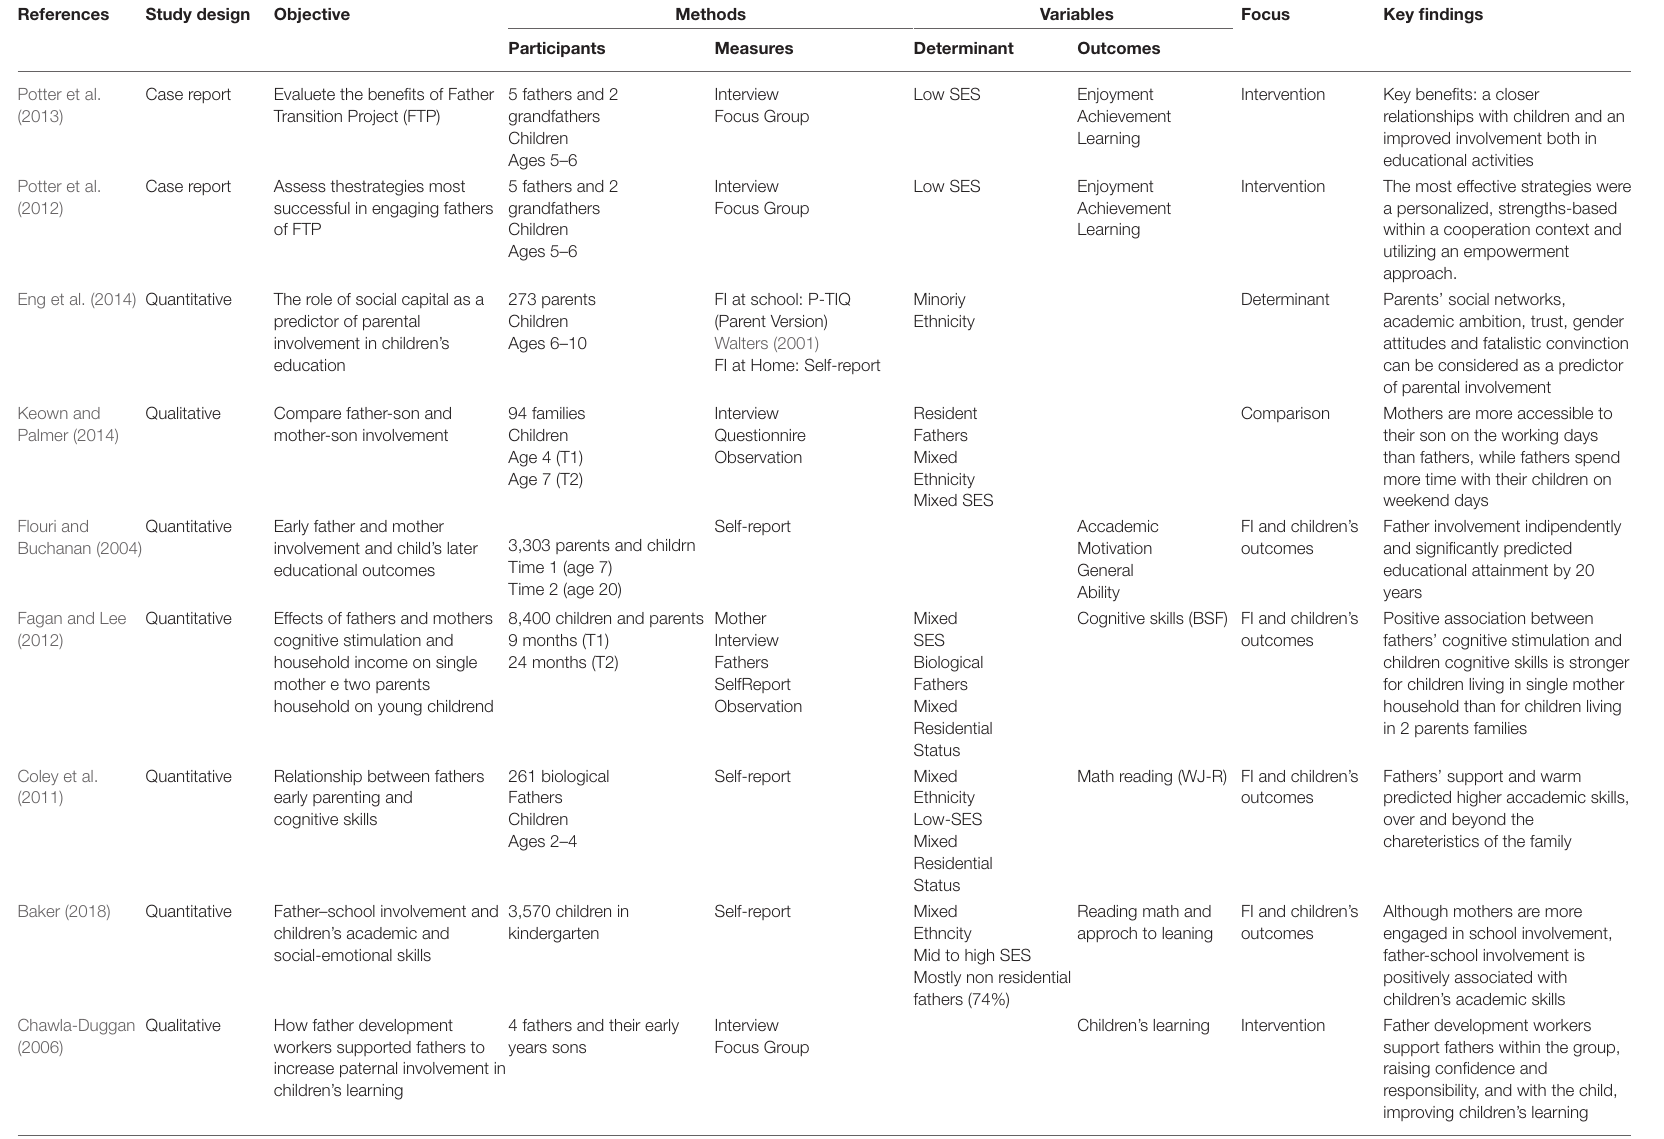
TABLE 3 | Studies included in the meta-analysis listed by author, year of study, type of document, objects, and